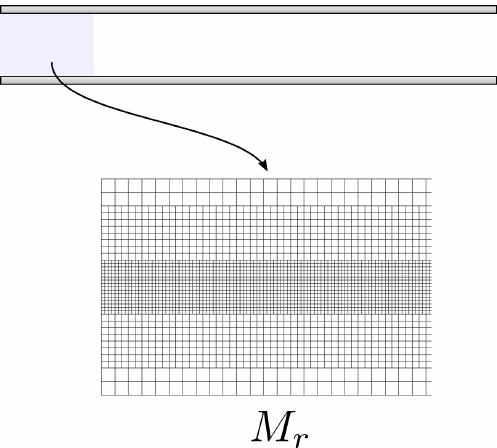
Figure 5. Mesh with refinement in the centerline region.